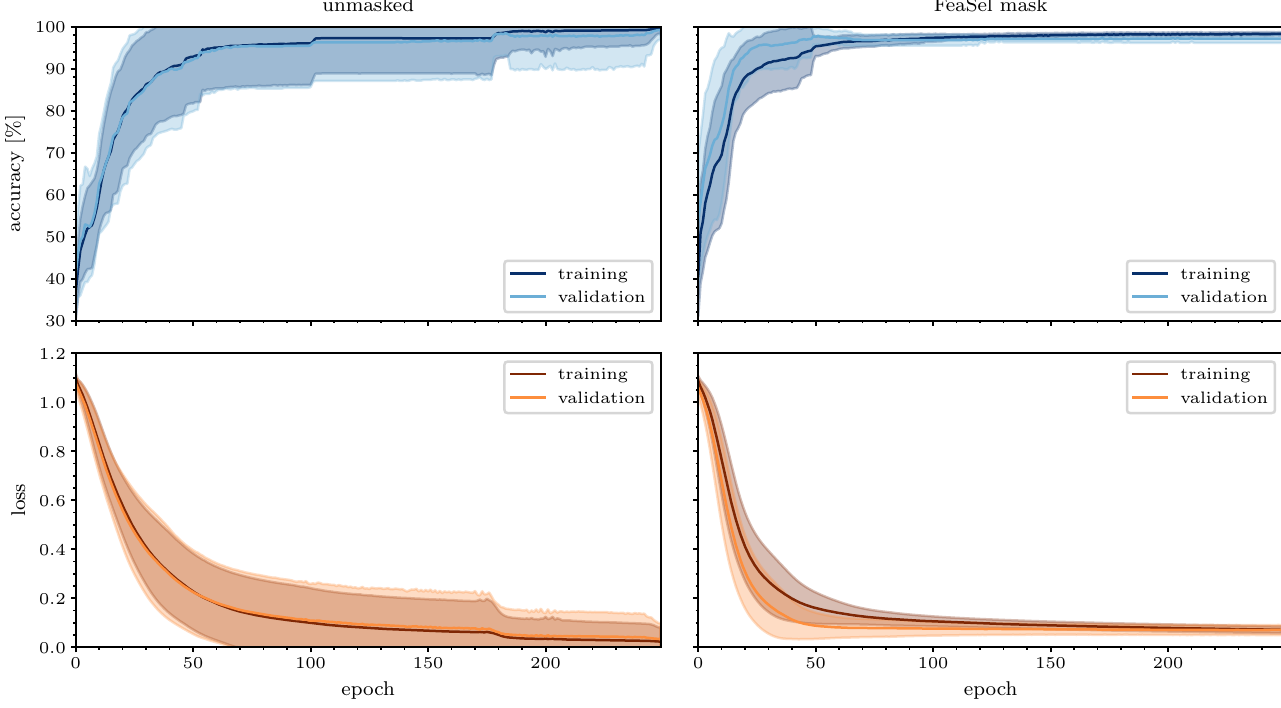
Figure 13. Comparison between the unmasked and masked Wine Classification dataset. The mask consists of the three most important features according to FeaSel-Net ( proline, flavanoids, and alcohol ). Darker lines indicate averages and colored, transparent areas represent the standard deviation of 25 optimization